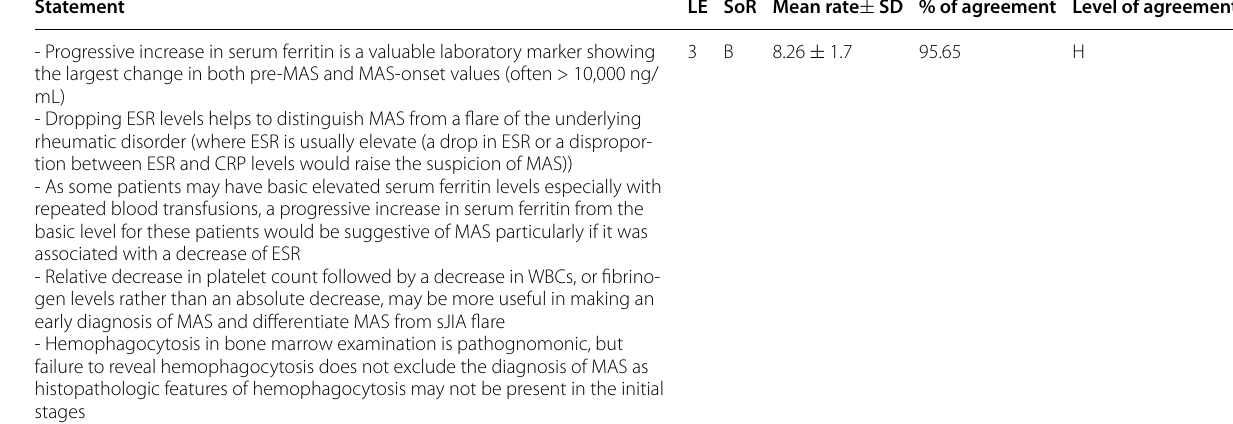
SD % of agreement Level of agreement ±